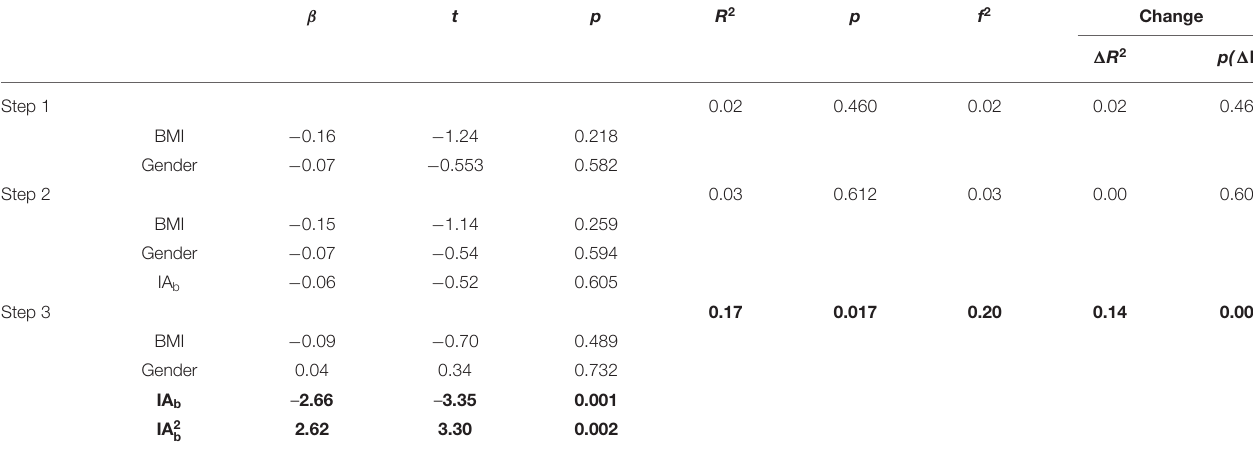
TABLE 2 | Hierarchical regression models of linear and quadratic relationships between alexithymia and baseline interoceptive